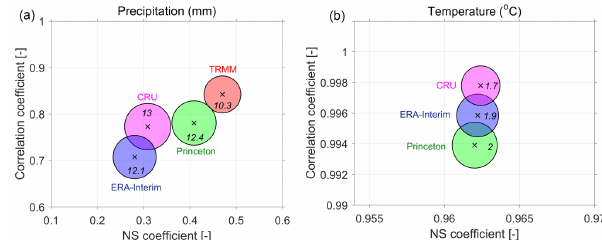
Figure 5. The correlation coefficient, NS coefficient, and RMSD (root mean square difference) computed between the local and dif- ferent global forcing data. The rms difference is shown as the radius of the circle (also explicitly provided as the